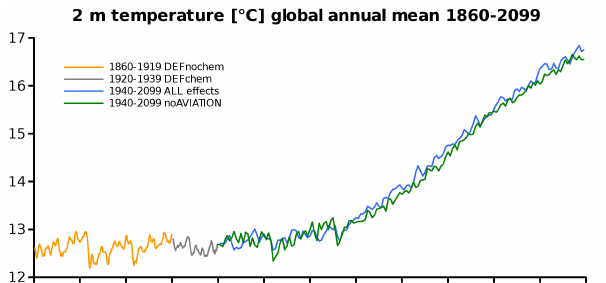
Fig. 5. Near-surface (at 2m) temperature evolution between 1860 and 2100 calculated by CNRM-CCM. The plot presents the ”ALL” and the ”noAVIATION” surface temperature for 1940–2100, the temperature from the chemical spinup run (DEFchem) for 1920– 1940 and the run without online chemistry (DEFnochem) for 1860– 2100.